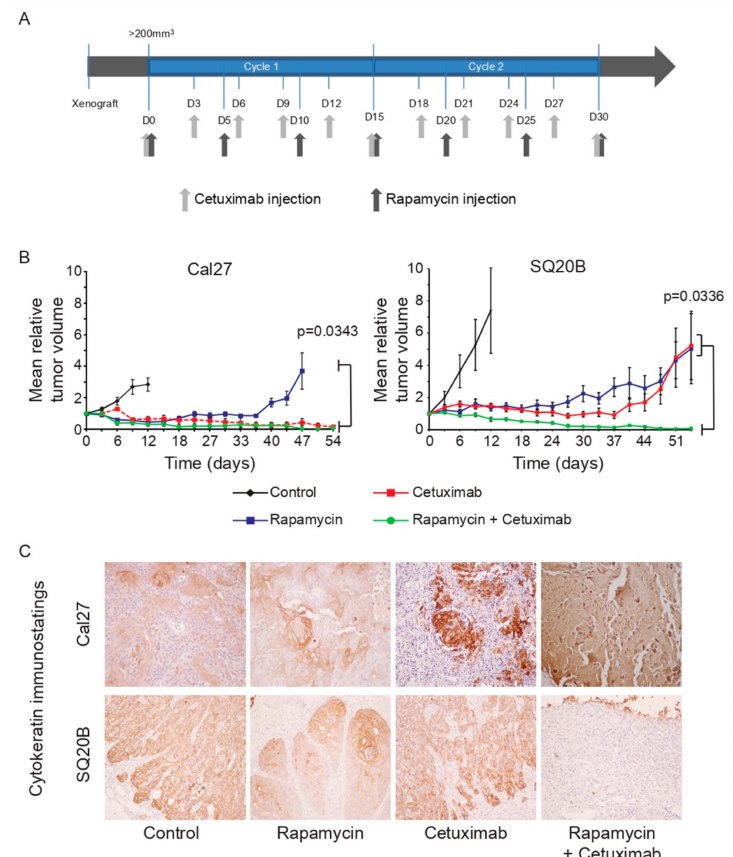
Figure 1. E ff ect of cetuximab and rapamycin treatment on SQ20B and Cal27 xenografts. ( A ) Treatment schedule of nude mice bearing Cal27 and SQ20B xenografts. ( B ) Mean relative tumor volume of Cal27 and SQ20B xenografts measured during and after treatment ( n = 10 tumors per group). Error bars represent the standard error in each panel. Statistical significance was evaluated after the completion of the 2 treatment cycles. Bracket show statistically significant di ff erences (Kruskal–Wallis p-values are shown). ( C ) Immunohistochemistry analysis of hematoxylin and pan-cytokeratin staining in xenograft tissue harvested from nude mice after the completion of the treatment. One representative micrograph is shown for each treatment arm for both cell lines. Pan-cytokeratin staining is visible in brown. Hematoxylin blue staining was used to counter-color the whole tissue. Please note: residual post-treatment Cal27 xenografts show no positive hematoxylin nuclei and display non-specific brown staining of necrotic tissue. Magnification: 20 ×